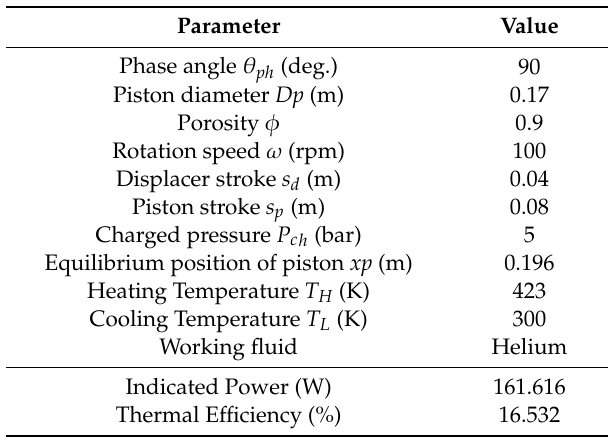
Table 2. Parameters with the baseline